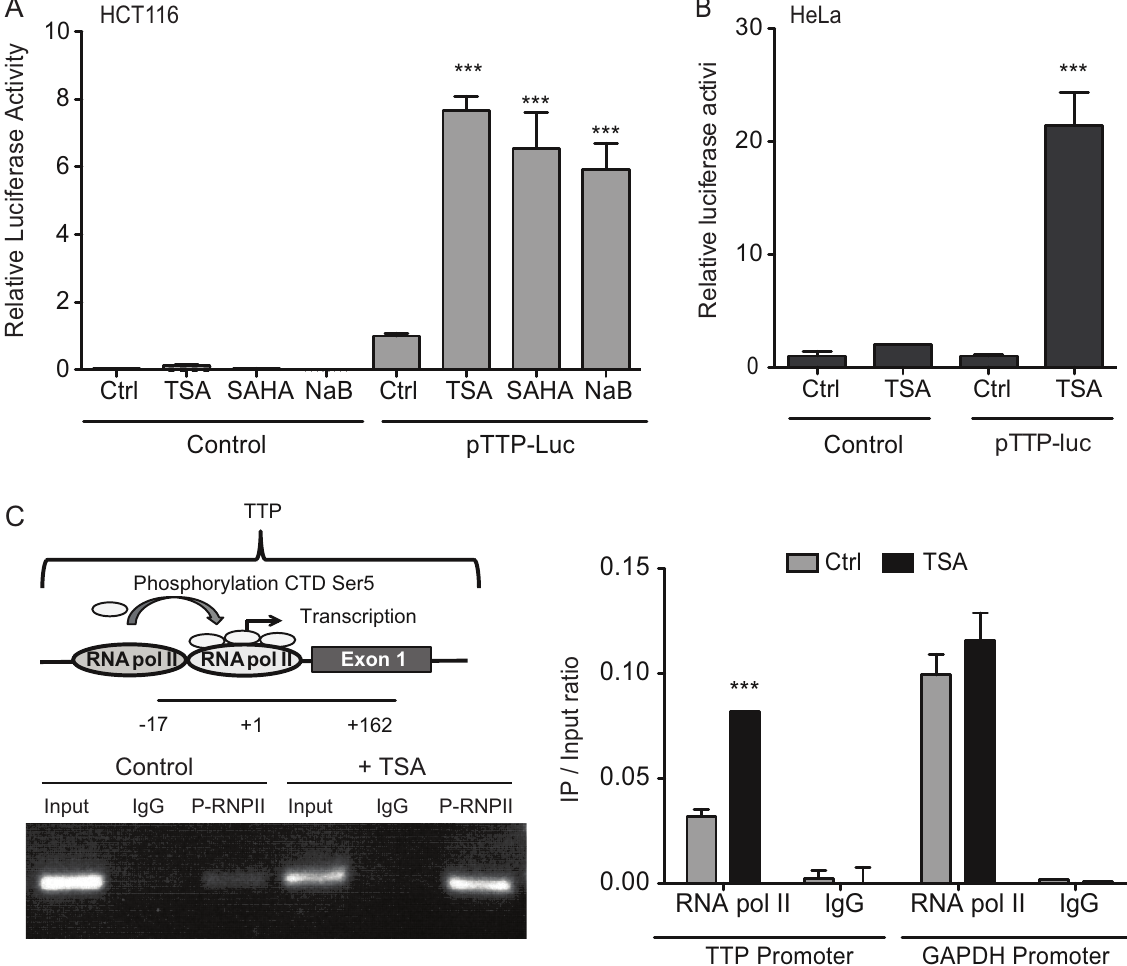
Figure 5. HDAC inhibitors increase TTP transcription. ( A and B ) HCT116 and HeLa cells were transfected with a luciferase reporter containing 659 bp of the human TTP promoter (pTTP-Luc) or control pGL3-Basic for 36 h, and treated with 0.4 (cid:3)M TSA, 5 (cid:3)M SAHA, or 5 mM NaB for 12 h. Luciferase activity was normalized to total protein. Values shown are normalized to Luc expression in the respective control-treated (Ctrl) cells and indicate the average of 3 independent experiments ± SD. ( C ) ChIP of phosphorylated RNA Pol II bound to TTP promoter. Sonicated chromatin from HCT-116 cells treated with 0.4 (cid:3)M TSA for 12 h was immunoprecipitated with anti-RNA pol II phospho-CTD (Ser5) or nonspecific IgG. PCR analysis of eluted DNA was performed using primers to amplify a 179 bp region ((cid:5)17/+162) of the ZFP36 promoter. 0.5% of input DNA is shown in ethidium bromide-stained gels. qPCR was used to quantitate fold-enrichment of ZFP36 promoter ((cid:5)17/+162) or control GAPDH promoter in respective ChIP reactions. The data are represented as the immunoprecipitated (IP) and input chromatin signal ratio and are the average of 3 experiments ± SD. *** p <